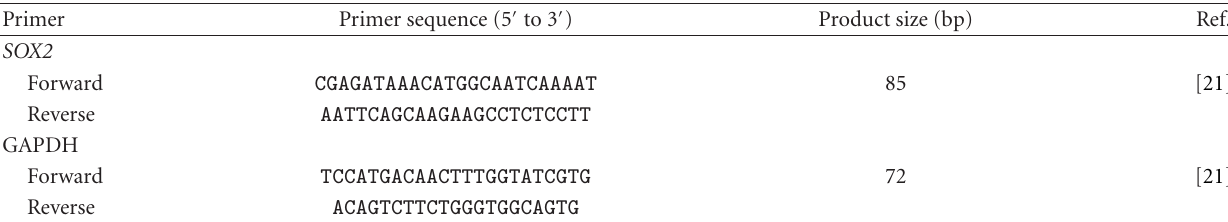
Table 2: Sequences of primers used in quantitative Real-Time RT-PCR